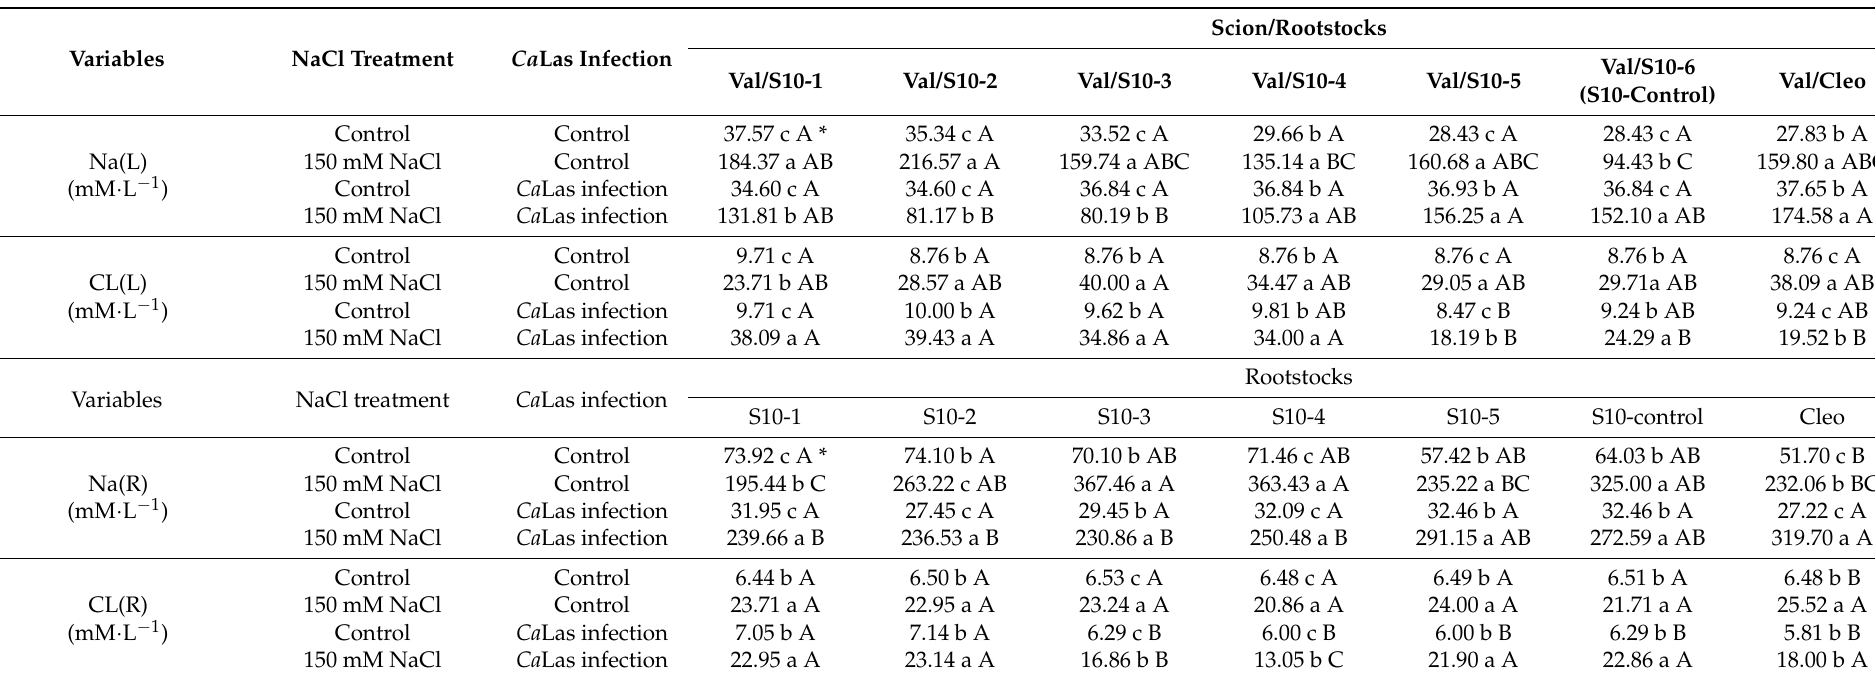
Table 4. Effect of NaCl treatment and Ca Las infection on sodium and chloride content in leaves of ‘Valencia’ sweet orange scions and roots of S10-derived rootstocks and Cleopatra mandarin